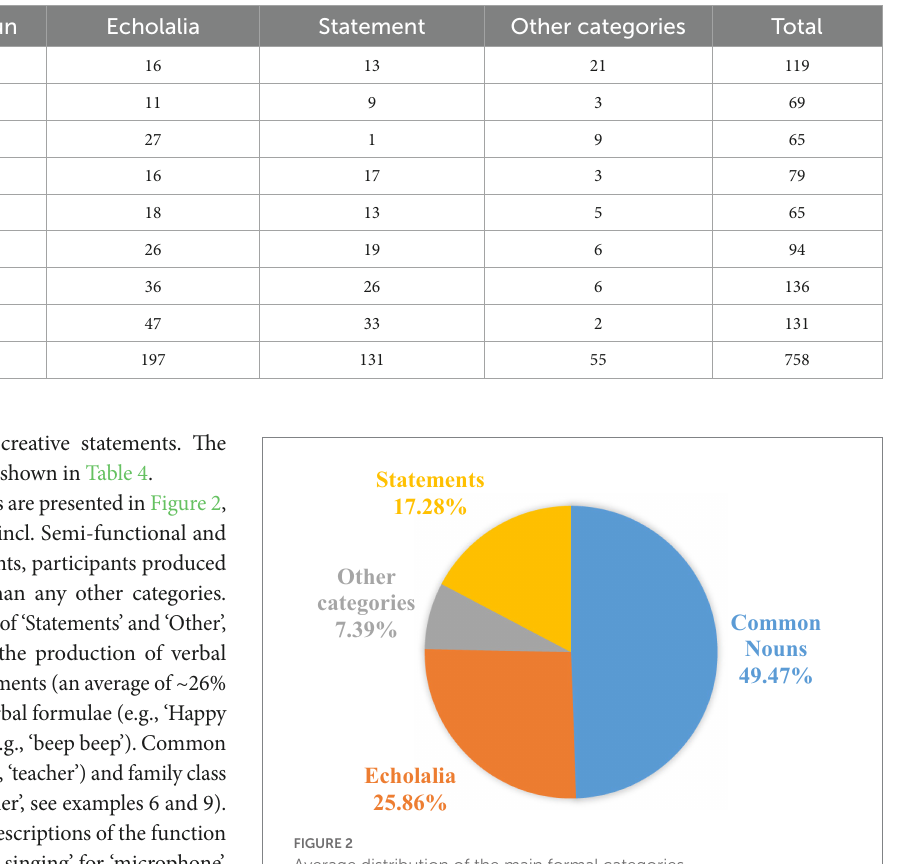
TABLE 4 Individuals’ production frequency of echolalia vs. common nouns and statements.